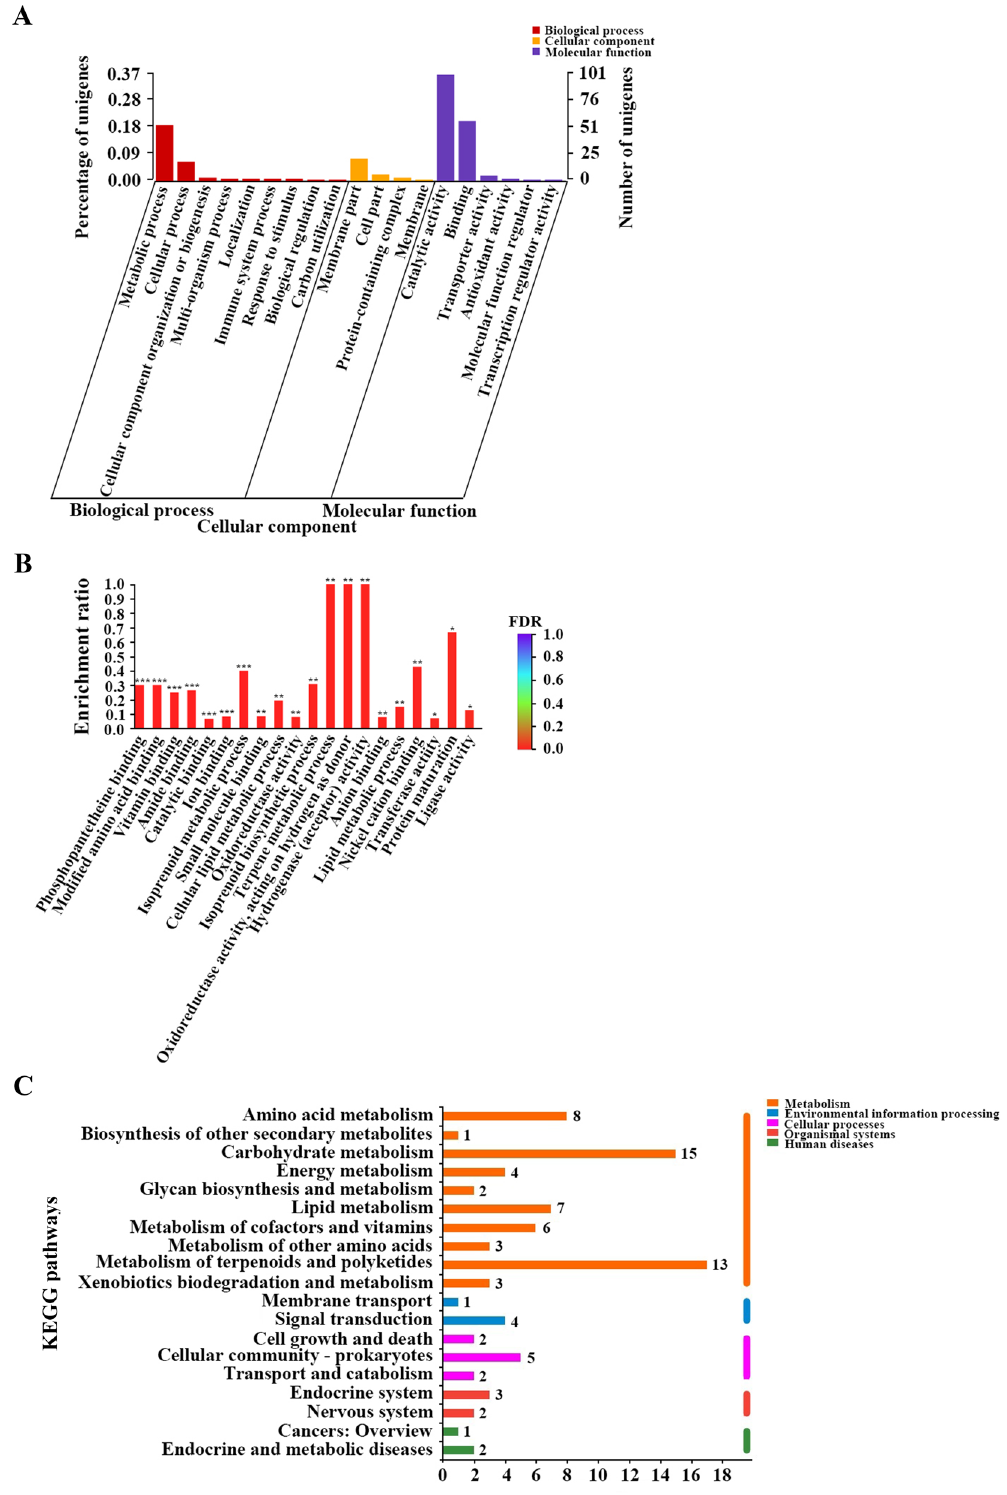
Figure 3. Annotation and enrichment of the up-regulated genes in S. spinosa S3-3. ( A ) GO annotation of the up-regulated genes in S. spinosa S3-3; ( B ) GO enrichment of the up-regulated genes in S. spinosa S3-3; ( C ) Annotation of the up-regulated genes in S. spinosa S3-3 using KEGG database. (The chart was carried out using Majorbio Cloud Platform. URL: http:// www. major bio.